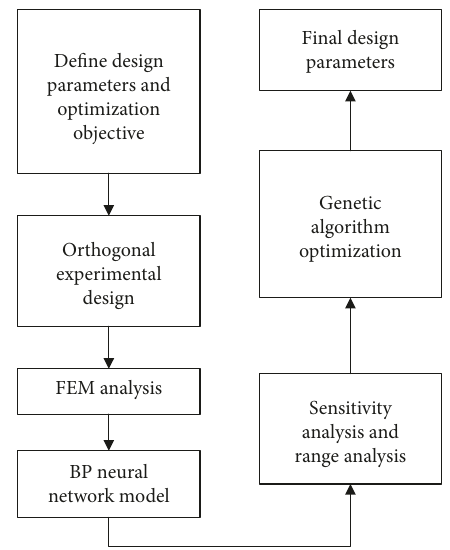
Figure 11: Comparison between the training results and the simulation results.